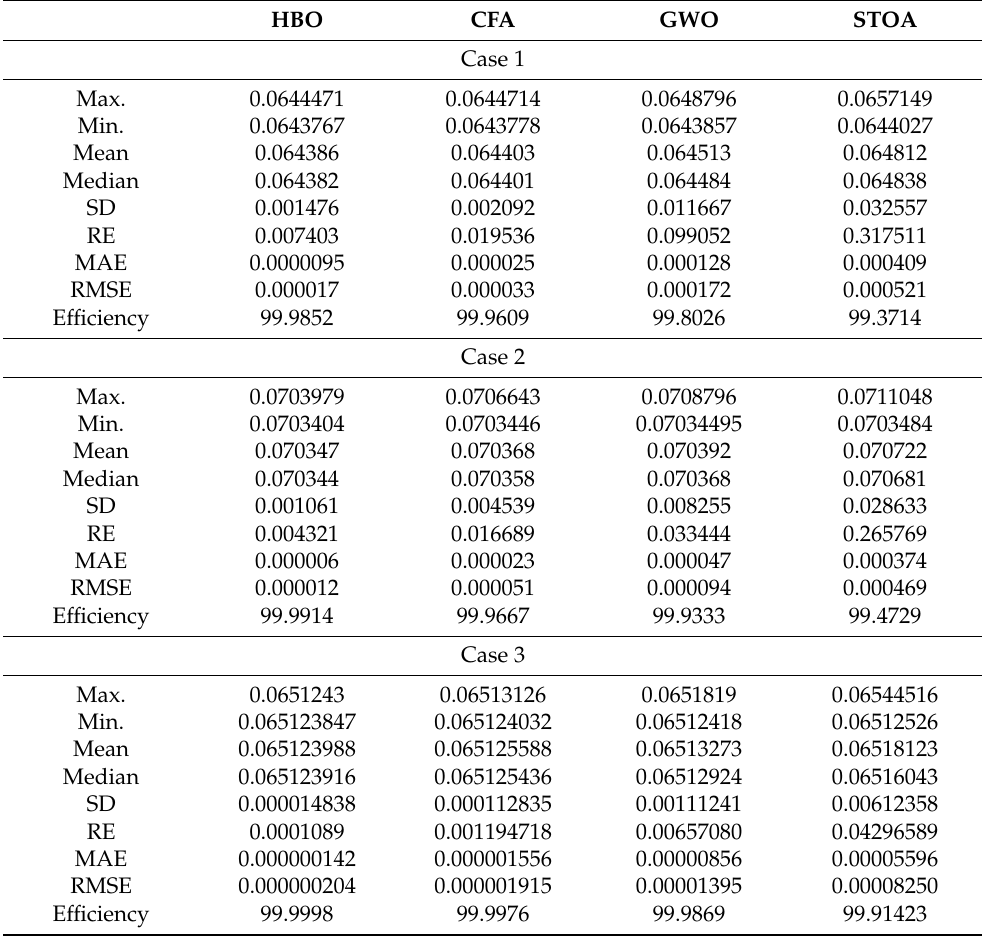
Table 10. The statistical performance of the studied optimization algorithms for the four system cases. HBO CFA GWO STOA Case 1